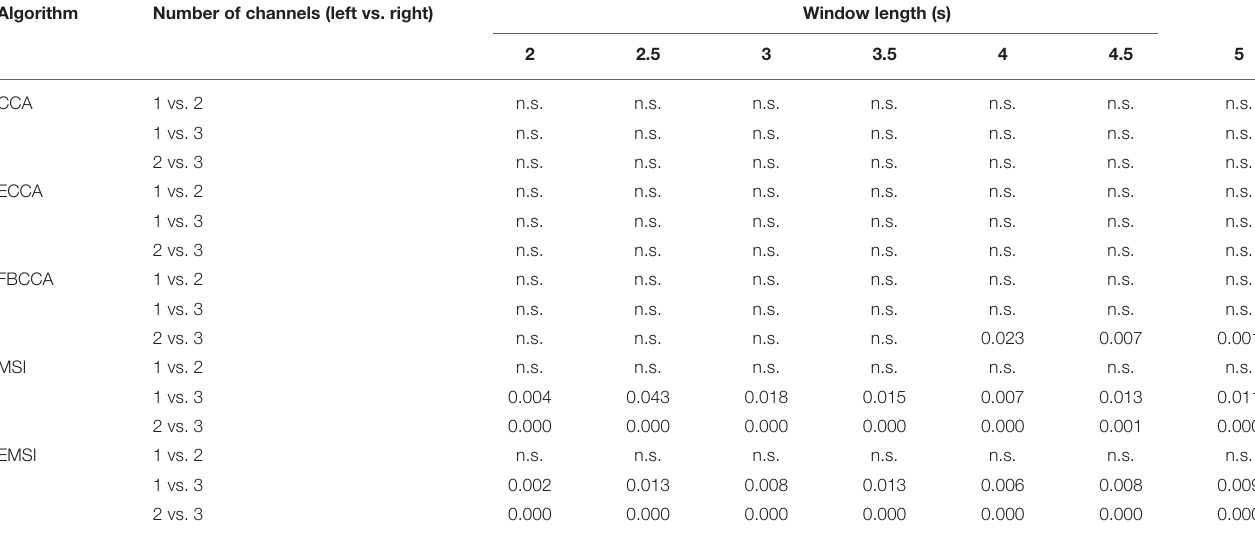
TABLE 4 | Bonferroni corrected p -values of post-hoc analysis among the robustness to the electrode shift (RES) in the cases with the number of channels as 1, 2, and 3 for classification algorithm and window length. Algorithm Number of channels (left vs.